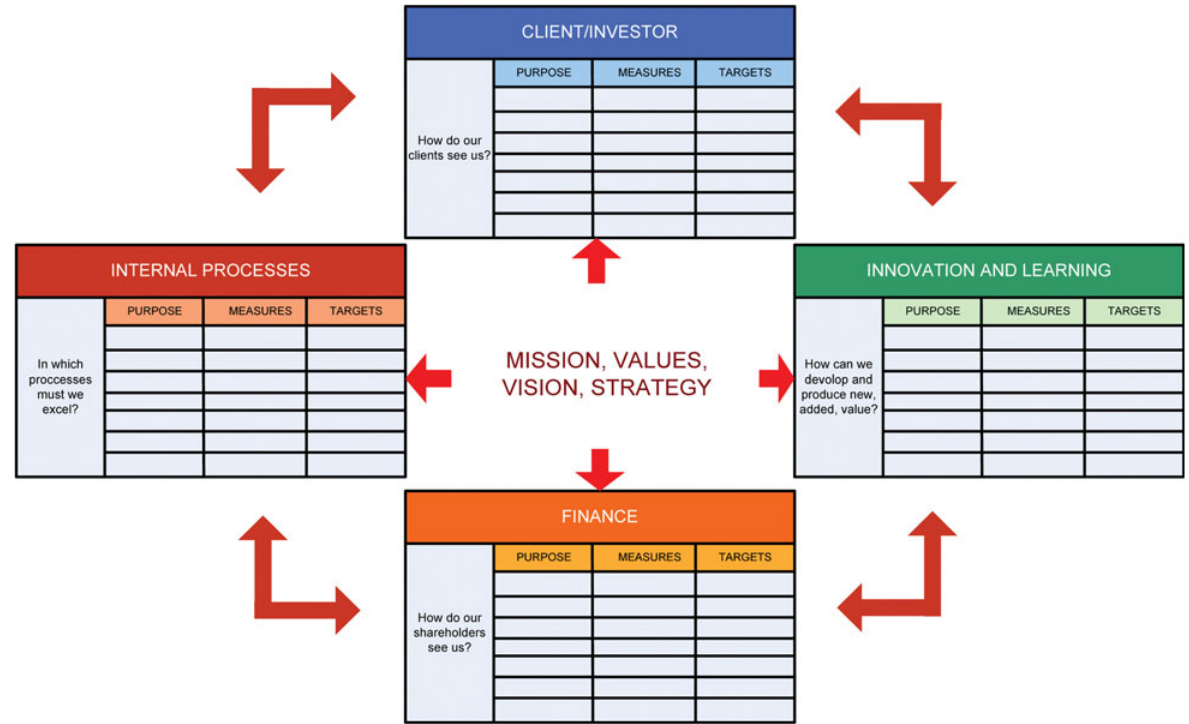
Fig. 1. The Balanced Scorecard (Kaplan, Norton 2005)